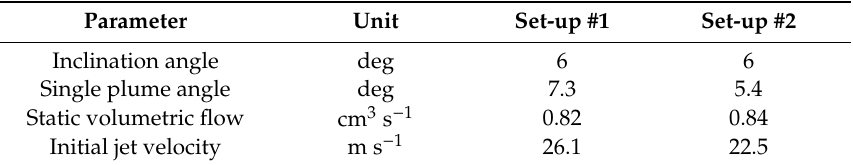
Table 5. Spray parameters used for simulations.